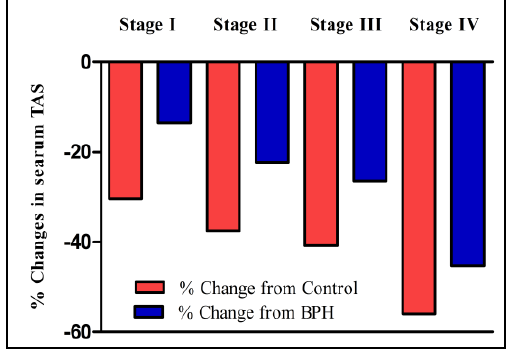
Figure 3: % differences in serum TAS levels in PCa patients with different stages of the disease compared to BPH patients and controls.